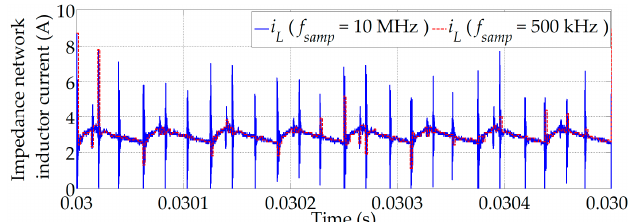
Figure 6. Waveform of the impedance network inductor current for the switching frequency of 8 kHz and sampling frequencies of 10 MHz and 500 kHz.